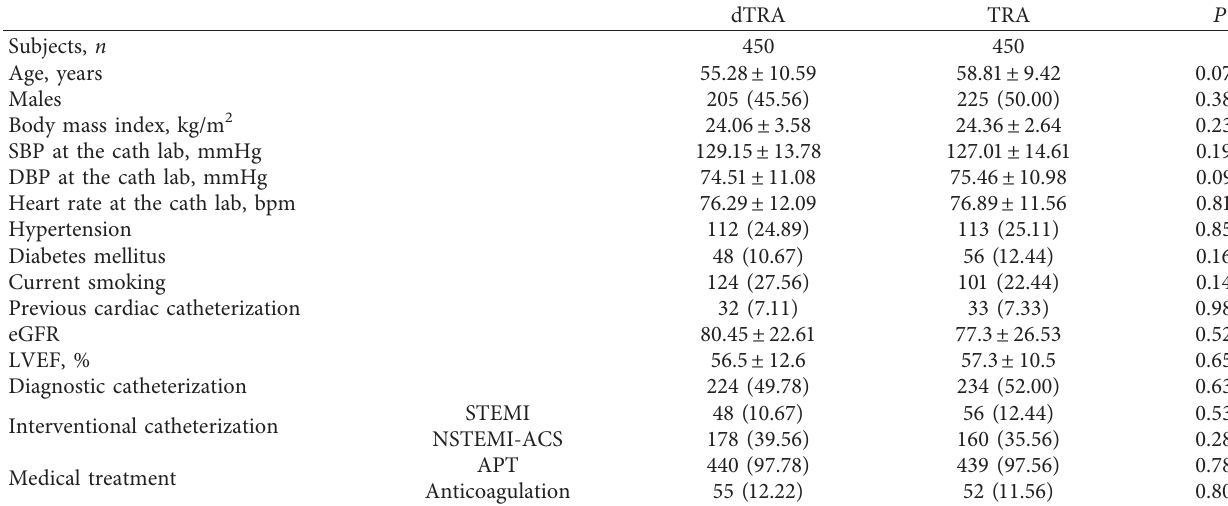
Figure 1: Catheterization by dTRA on the right side. (a) Patient's position for the right snuffbox approach. The arm is pronated with the anatomical snuffbox upward. (b) Insertion of the 6 French introducer sheath (Terumo). (c) Hemostasis of the puncture site by manual compressive bandage with gauze. Table 1: Baseline characteristics of the dTRA and TRA groups ∗